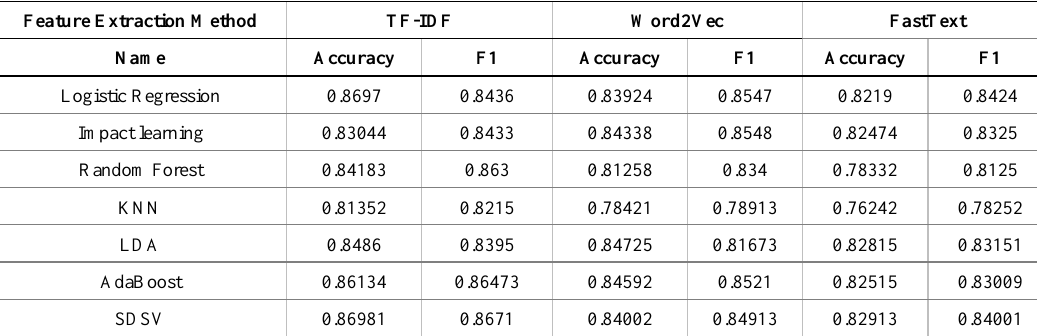
Table 2. Multiclass classification result: Amazon fine food review